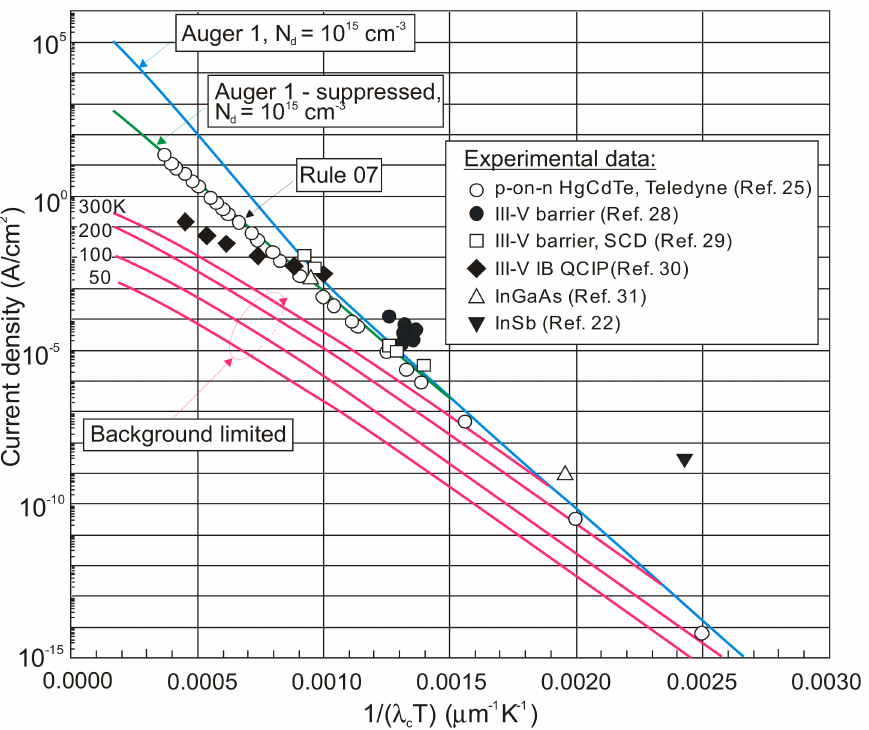
Figure 4. Current density of p-on-n HgCdTe photodiodes versus 1/( λ c T) product (adapted after reference [25]). Experimental data is gathered for Teledyne Technologies and alternative technolo- gies